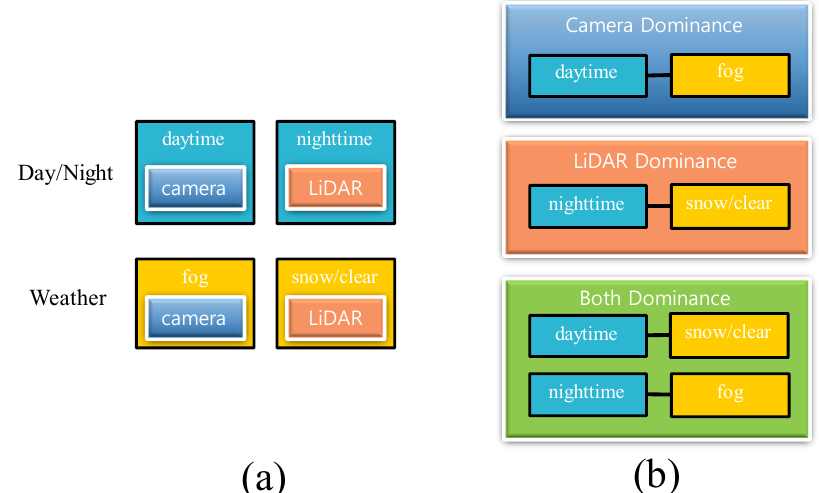
Figure 5. Day and night, weather-dependent sensor dominance. ( a ) Each sensor represents a ro- bust situation. ( b ) Dominance is used in experiments and establishing rules based on the robust sensor.